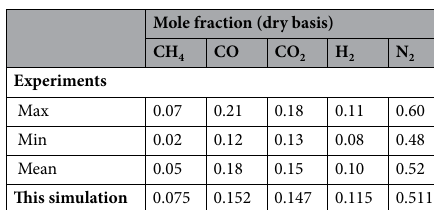
Mole fraction (dry